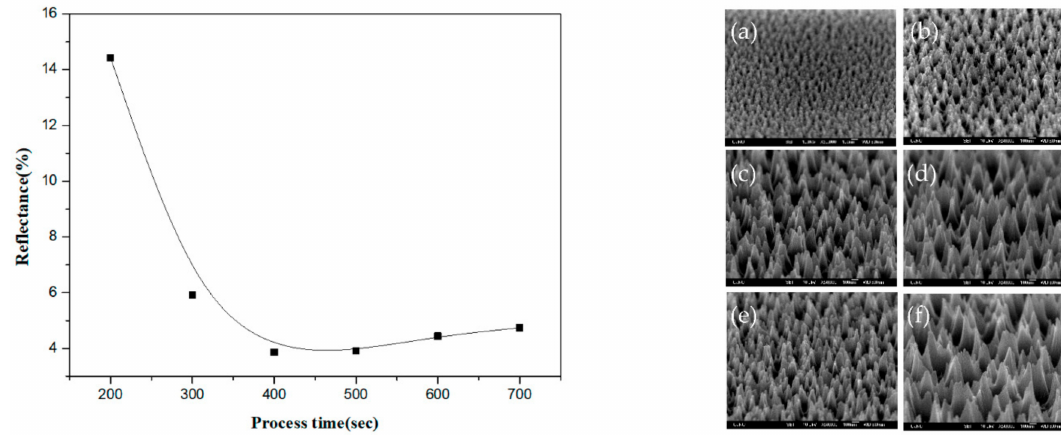
Figure 8. Reflectance and cross-section SEM images of wafer surfaces according to etching time for the RIE process: ( a ) 200 s, ( b ) 300 s, ( c ) 400 s, ( d ) 500 s, ( e ) 600 s, and ( f ) 700